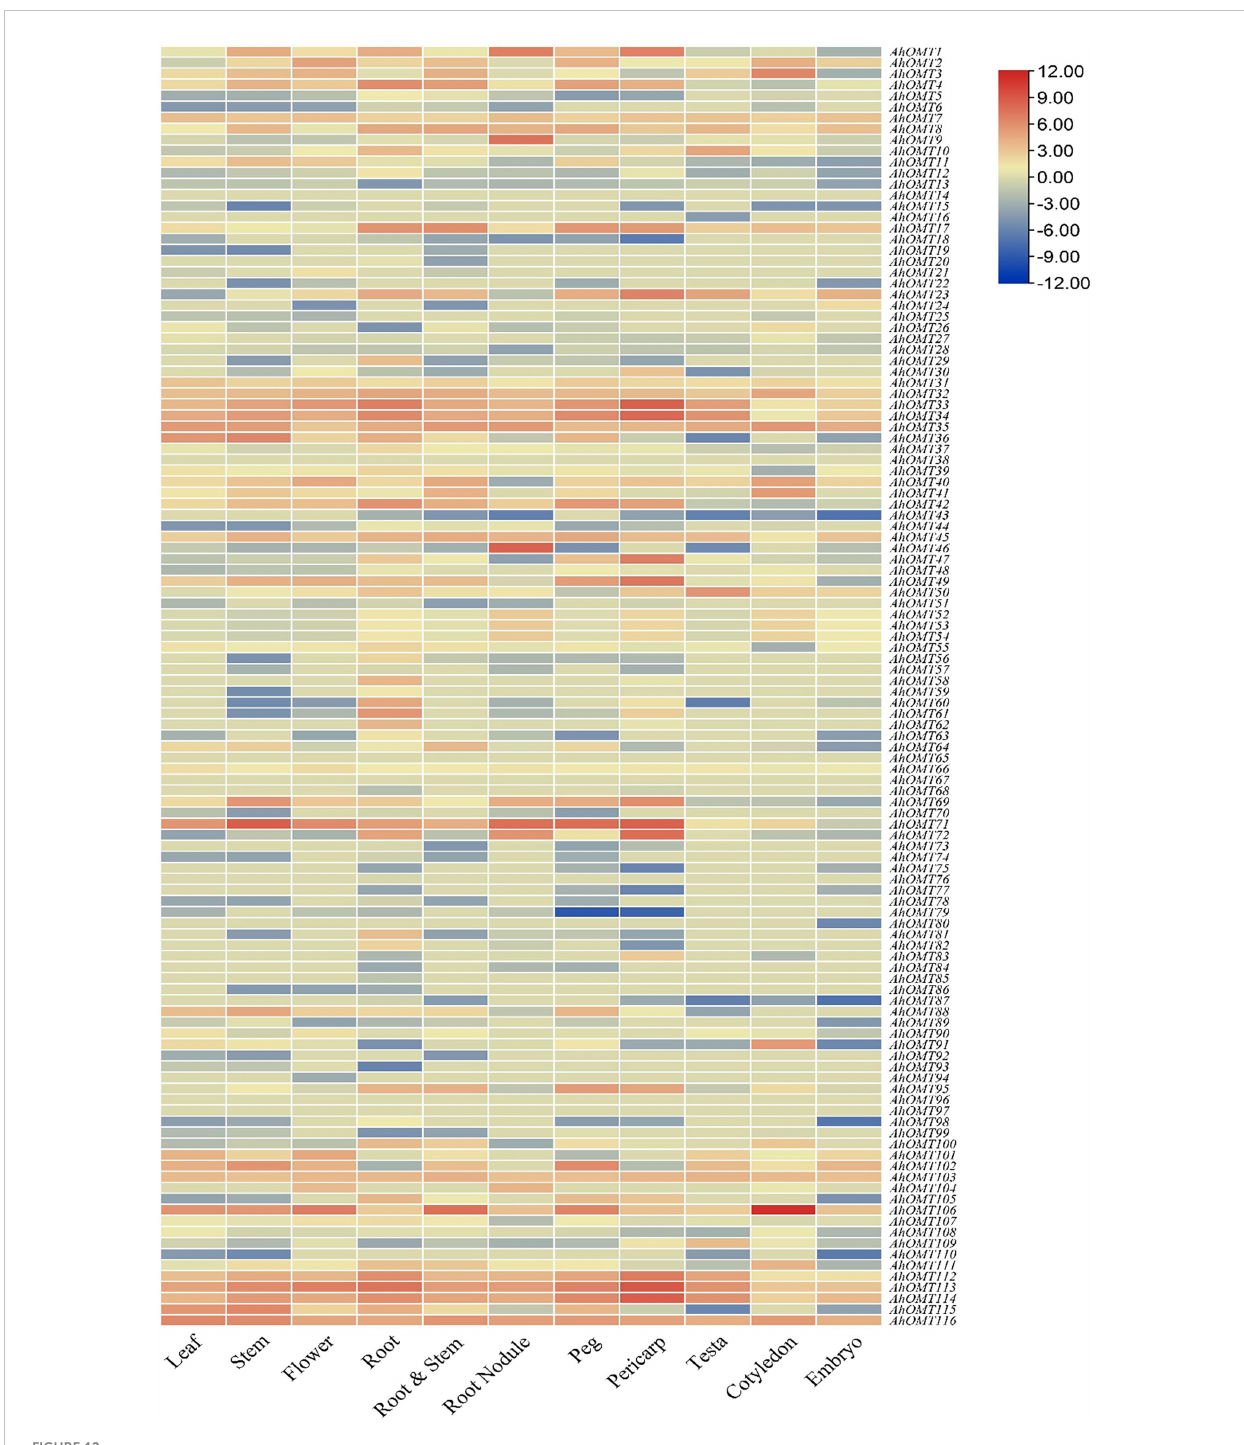
FIGURE 12 Transcriptome expression of AhOMTs in different tissues. AhOMTs possessed varying expression matrix in different tissues. All genes possessed varying levels of expression in different